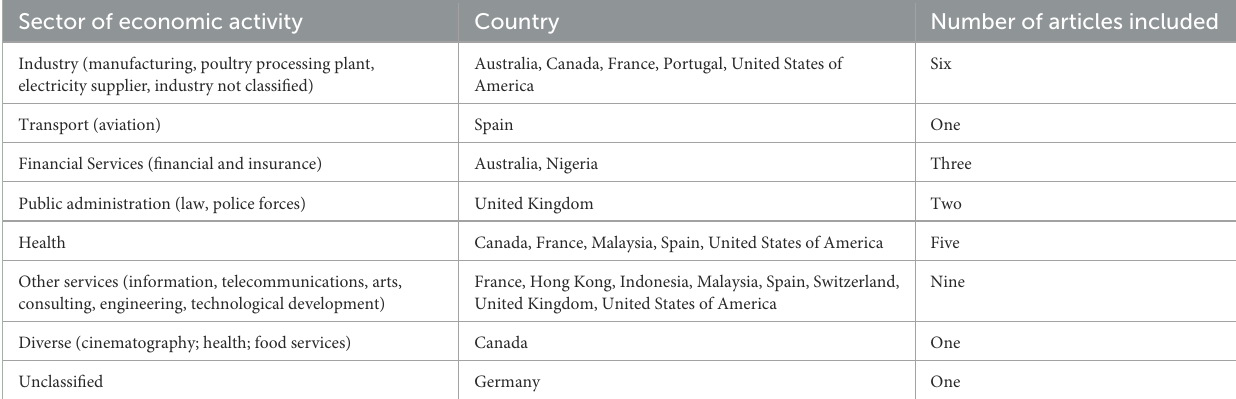
TABLE 2 Characterization of articles by sector and country of the study (organized by sector of economic activity). Sector of economic activity